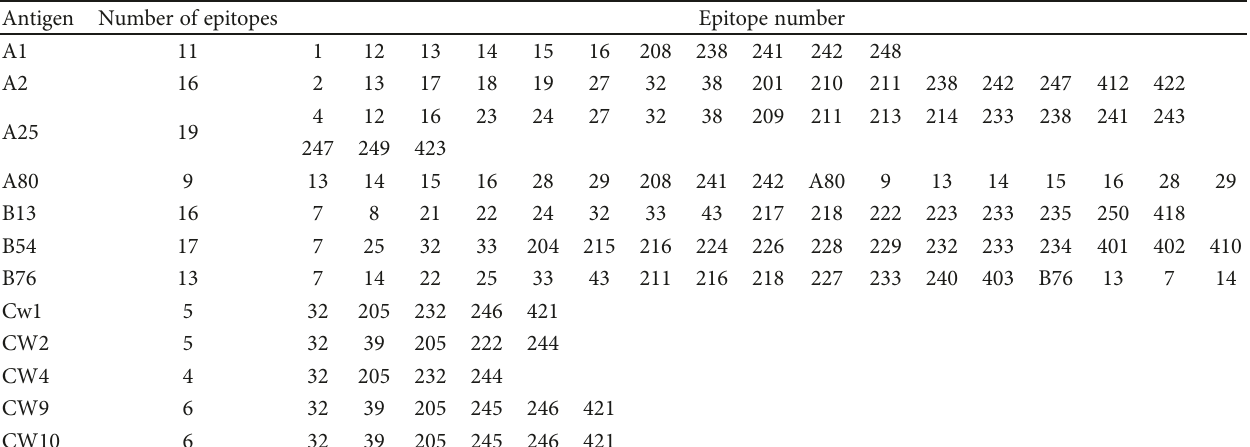
Table 3: Partial list of epitopes on HLA class I antigens. Complete list in supplemental fi le. Antigen Number of epitopes